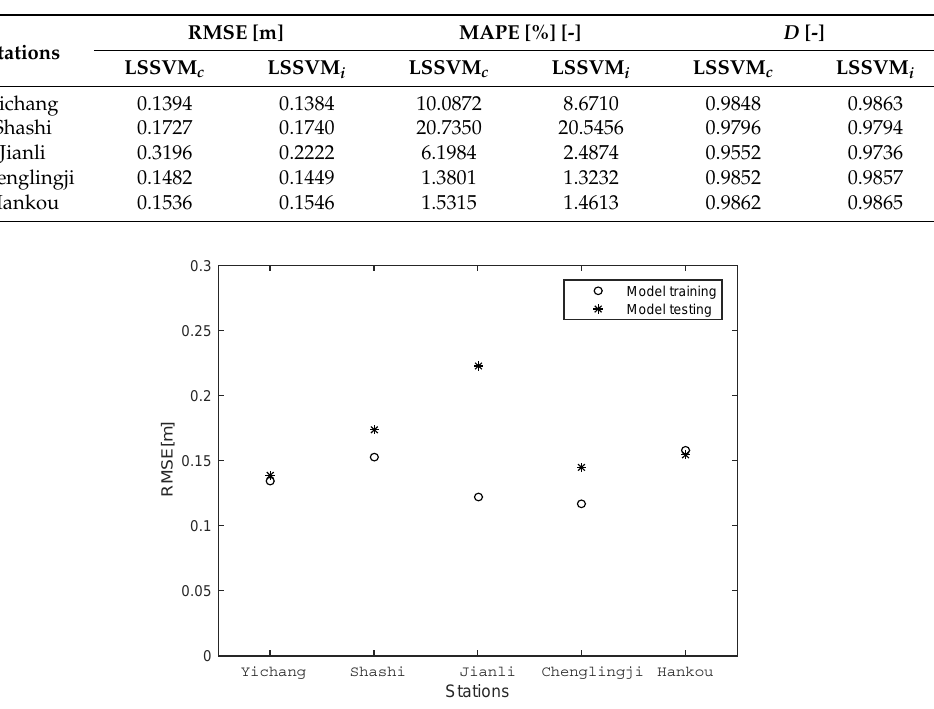
Figure 6. RMSE computations for model training and testing at all five stations. Figure 6 . RMSE computations for model training and testing at all five stations. Table 2 . Computation results of RMSE, MAPE and d for LSSVM c and LSSVM i.